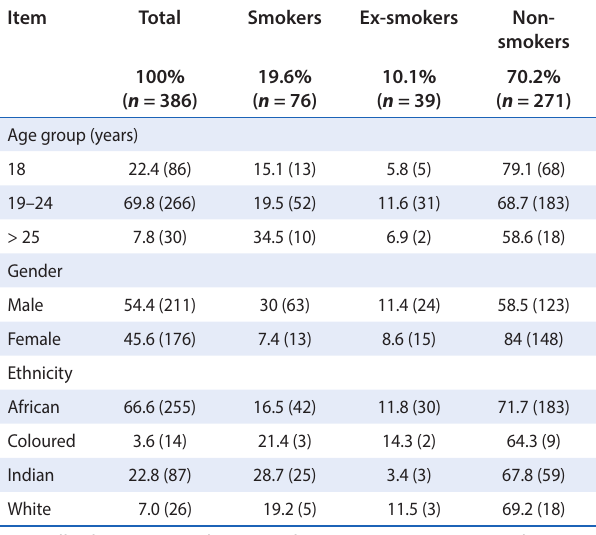
Note: All sub-categories do not total 386 as some participants chose not to answer some questions.